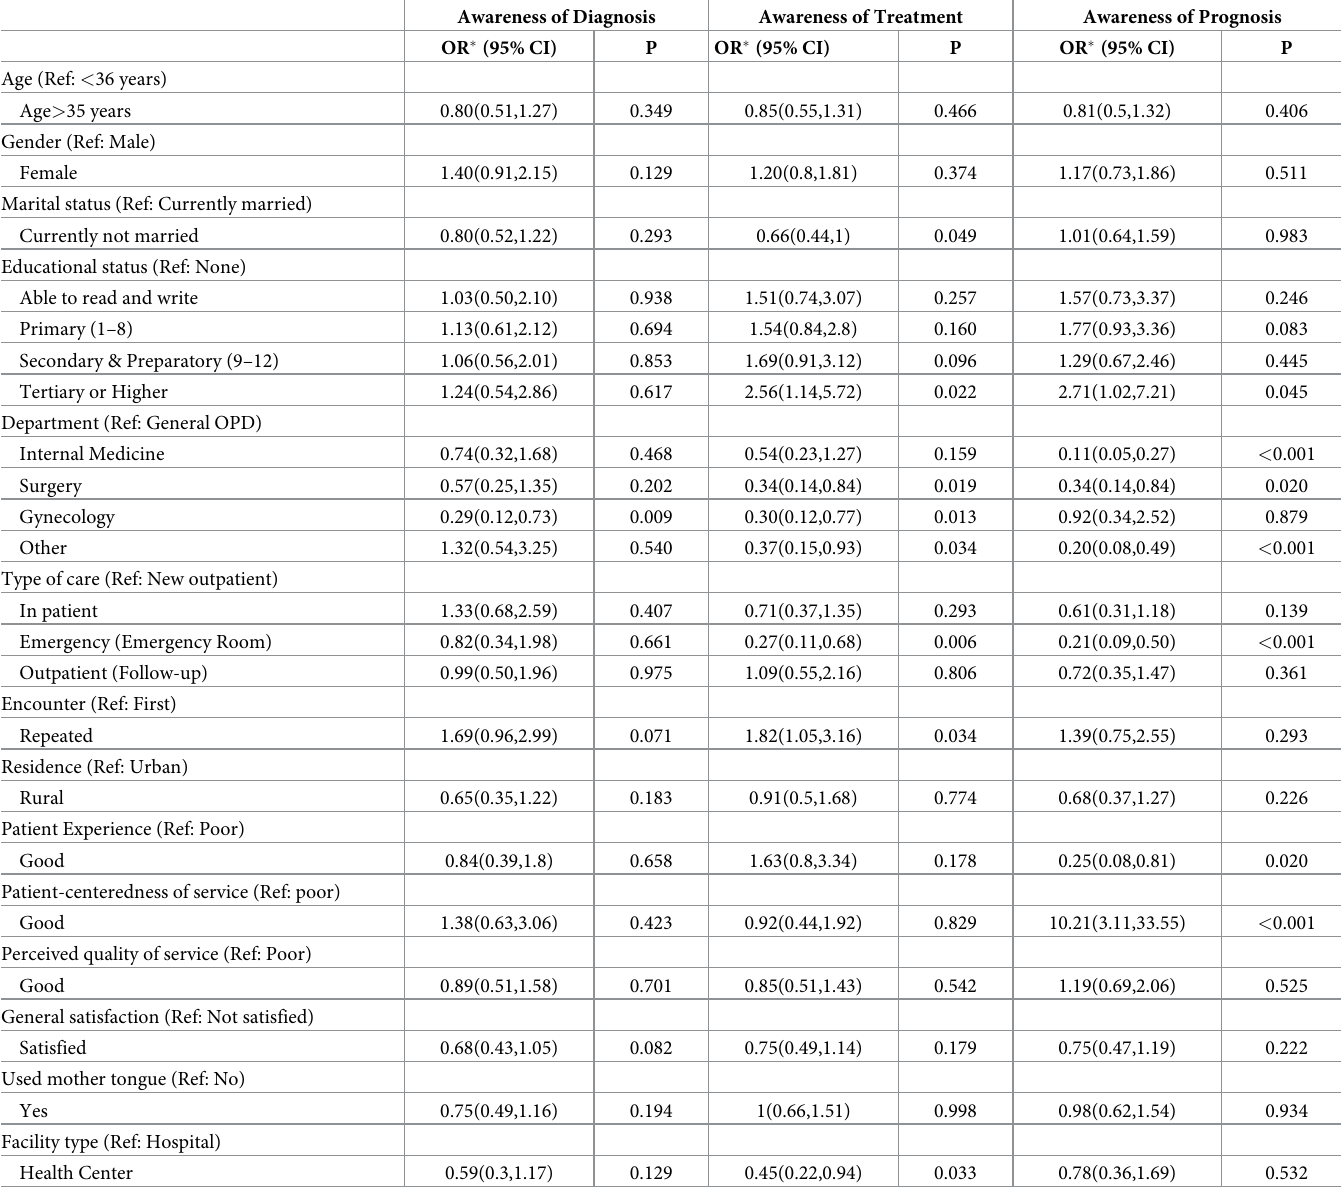
Table 3. Factors associated awareness of diagnosis, treatment plan and prognosis from multiple logistic regression